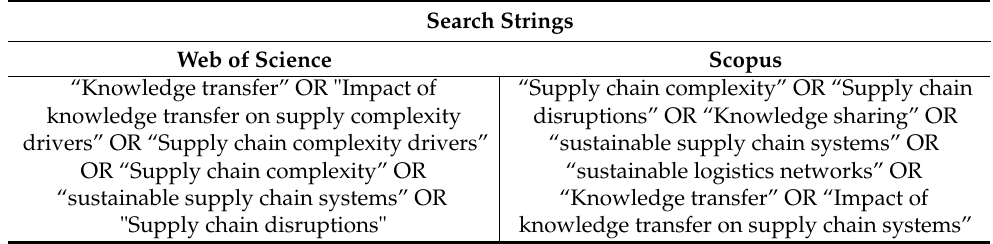
Table 1. Search strings used for collecting the studies from the databases. Search Strings Web of